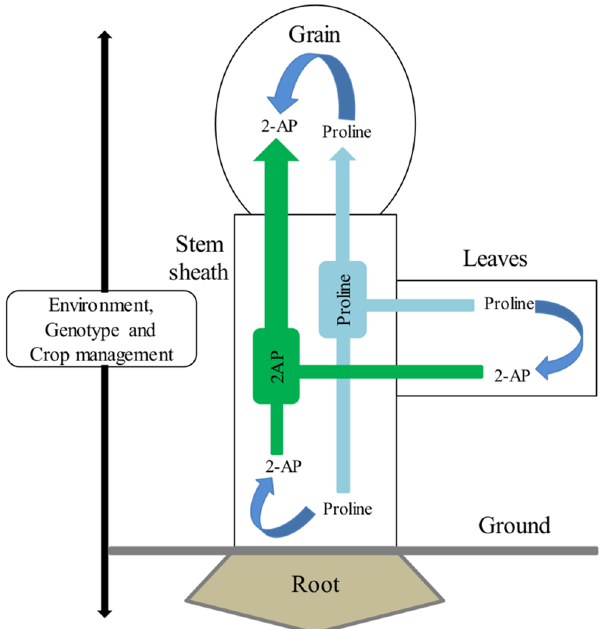
proline might accumulate directly in the grains, where it is further converted into 2-AP through various biochemical pathways. Environmental factors, crop genotype, and crop management practices affect rice